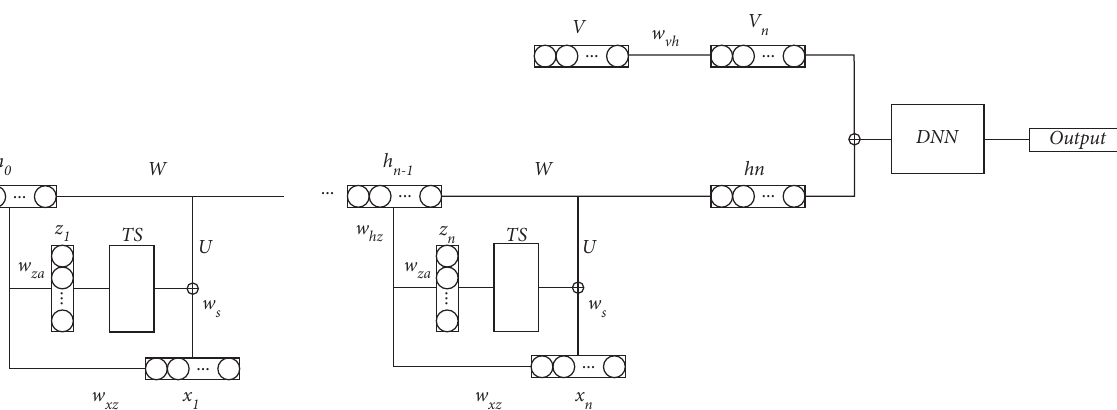
Figure 1: Graphical structure of travel energy consume prediction model. Our model employs attention mechanism in RNN to extract features from traffic states of road network. We use a one hidden layer neural network (NN) to extract features of vehicle states and concatenate the output of RNN and NN as the input of the DNN. The output of DNN is the final prediction result of our